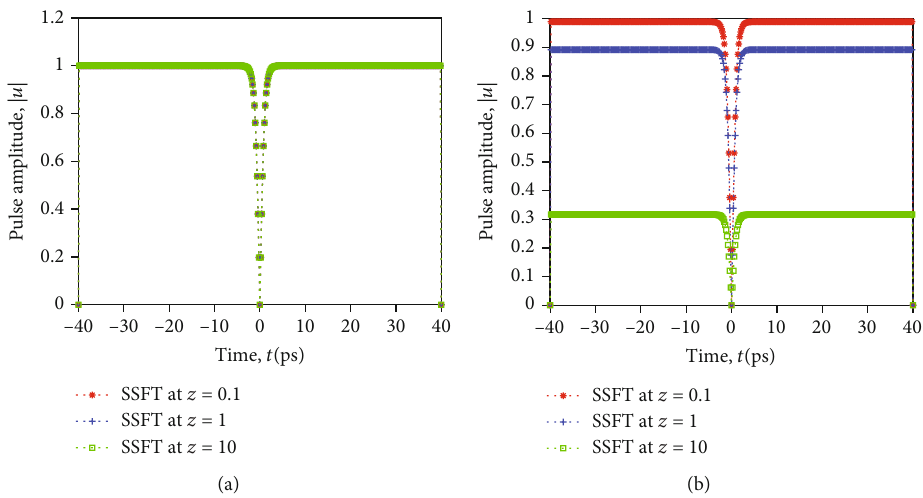
Figure 9: The split-step Fourier transform (SSFT) approximate solution for a lossless (a) and lossy (b) optical fi ber at a higher value of GVD = +20ps 2 /km when the input pulse is a dark soliton at distances z = 0 : 1, 1, 10 km, of β 2